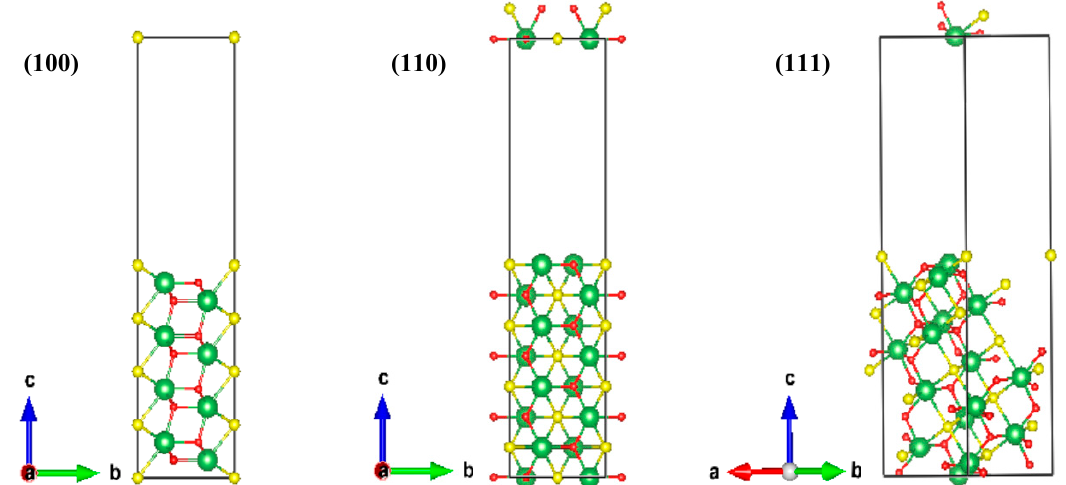
Figure 10. Slab models of the three low-indexed crystallographic planes of La 2 O 2 S. Green balls refer to La elements, yellow balls refer to S elements, and red balls refer to O elements. The left is (100) crystallographic planes, the middle is (110) crystallographic planes and the right is (111) crystallographic planes of La 2 O 2 S. The arrows of a, b, and c refer to the three directions in rectangular coordinates. Table 4. Vacuum static potentials of inclusions and the Fe matrix at three different low-indexed crystallographic planes (eV).